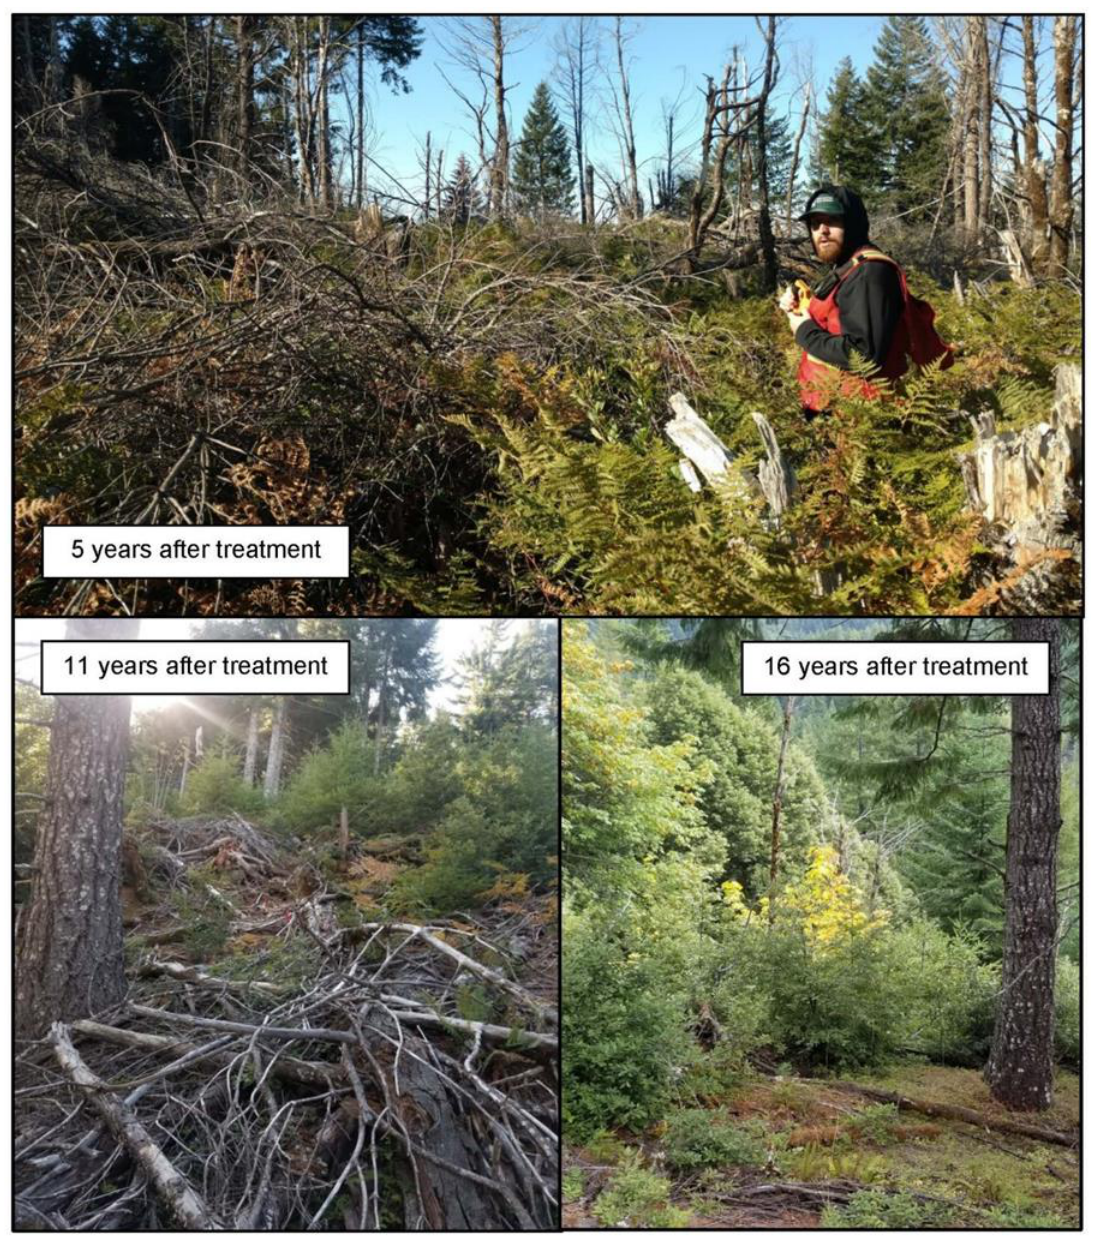
Figure 3. Chronosequence of surface fuels after frill treatment of tanoak at Little Pine Creek. At Lupton Creek, we installed 10-m Brown’s planar intercept transects [16] oriented at randomly-selected cardinal directions (N, S, E, or W) that all terminated at one randomly-selected corner of a 0.2-ha square fixed-area forest inventory plot. The two no-treatment control plots each had three transects for a total of six transects. The treatment plots had 2–3 transects for a total of five transects. At Little Pine Creek, we installed five 10-m Brown’s fuel transects in each stand at random start locations with random azimuth, giving fuel depth and loading for a single stand that underwent rehabilitation frill treatment in 2002, a second stand treated in 2007, and a third stand treated in 2013, for a total of 15 transects. Fuels data were collected in autumn of 2018.